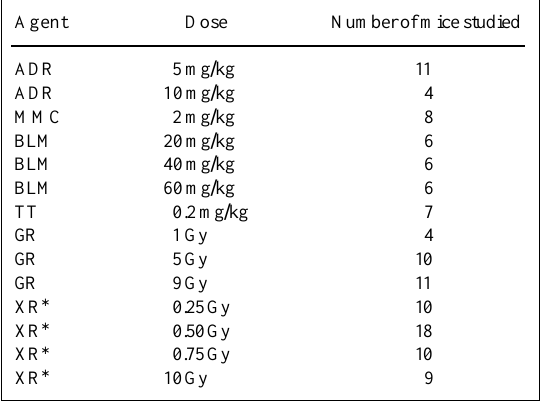
Table I - Experimental protocol employed to compare reciprocal transloca- tion type induced by the different treatments. Agent Dose Number of mice